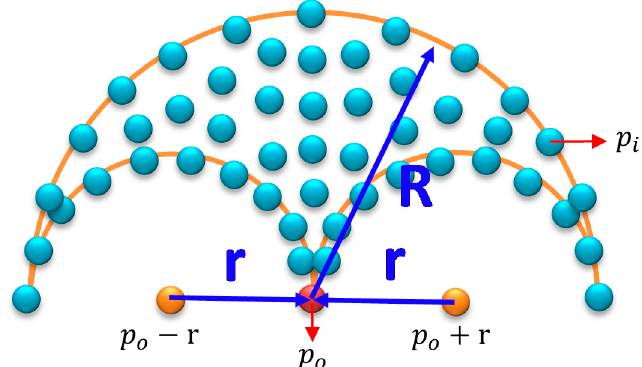
Figure 10. Drivable moving region (DMR).